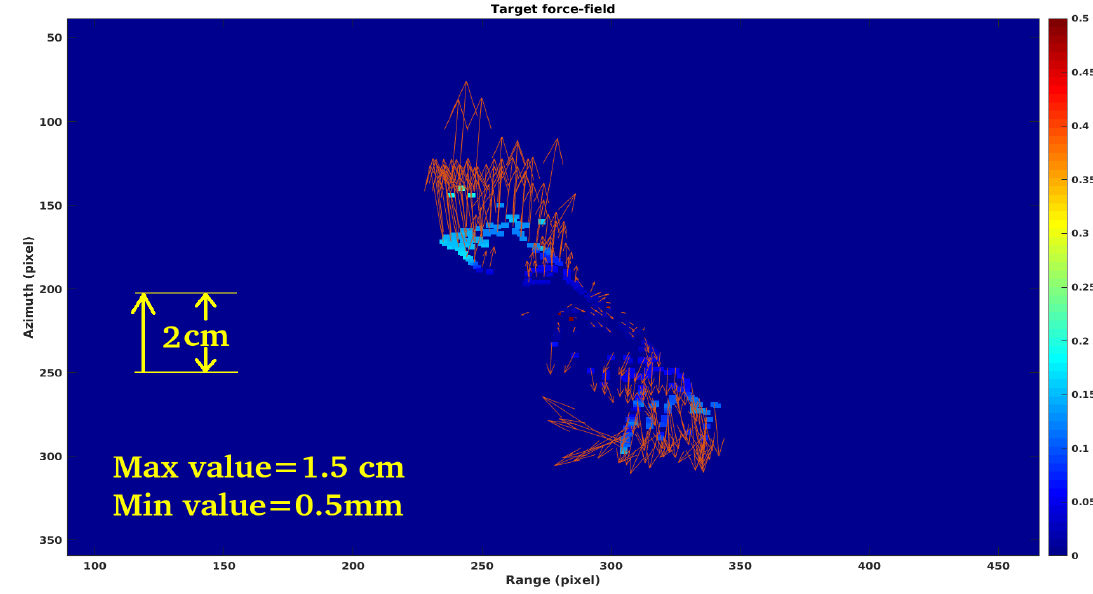
Figure 14. Complex velocity